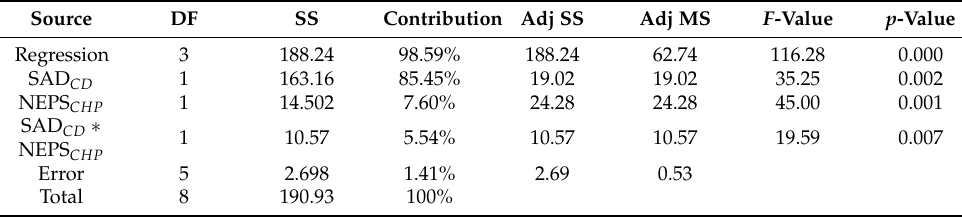
Table 10. ANOVA results for the Cook dinner PLSR model.